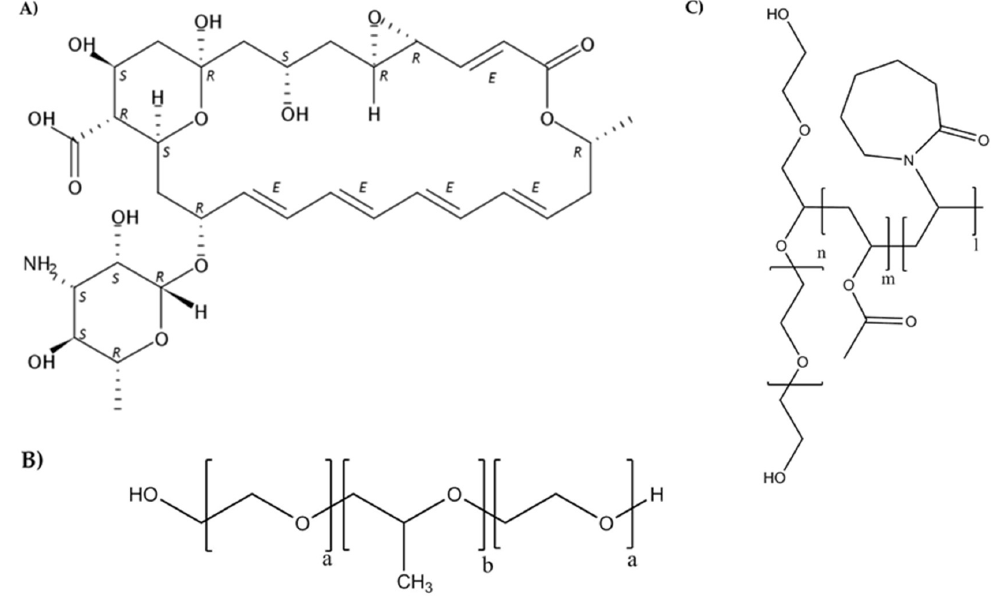
Figure 1. Chemical structures of natamycin ( A ), Pluronic ® ( B ), and Soluplus ® ( C ).